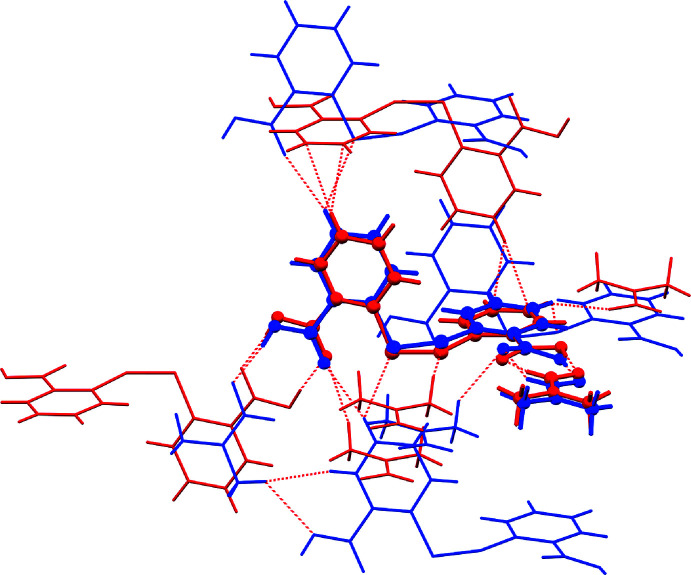
A comparison of crystal packing similarity within a 20% geometric tolerance between (I) (red trace) and (II) (blue) with the overlapped mol­ecules represented in ball-and-stick mode.